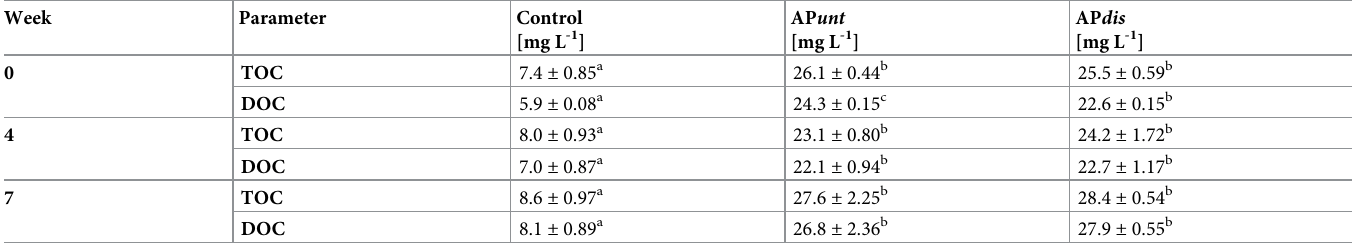
a,b,c significant differences are indicated by different superscript small letters (p <